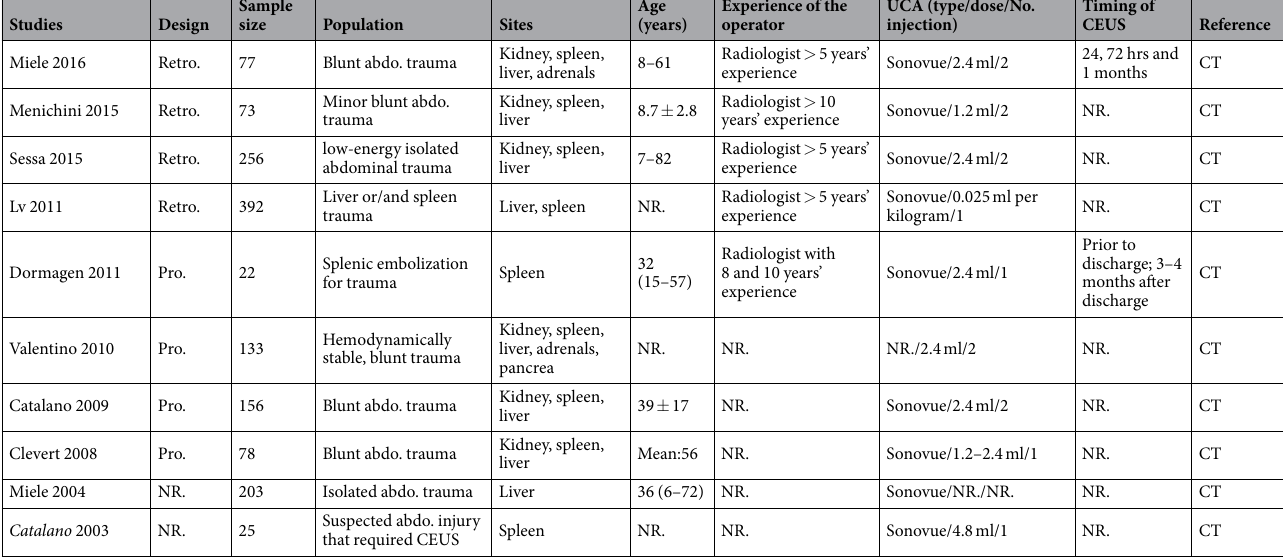
Table 2. Characteristics of included studies. Abbreviations: Retro.: retrospective; Pro.: prospective; NR.: not reported; CT: computed tomography; CEUS: contrast enhanced ultrasound; abdo.: abdominal.